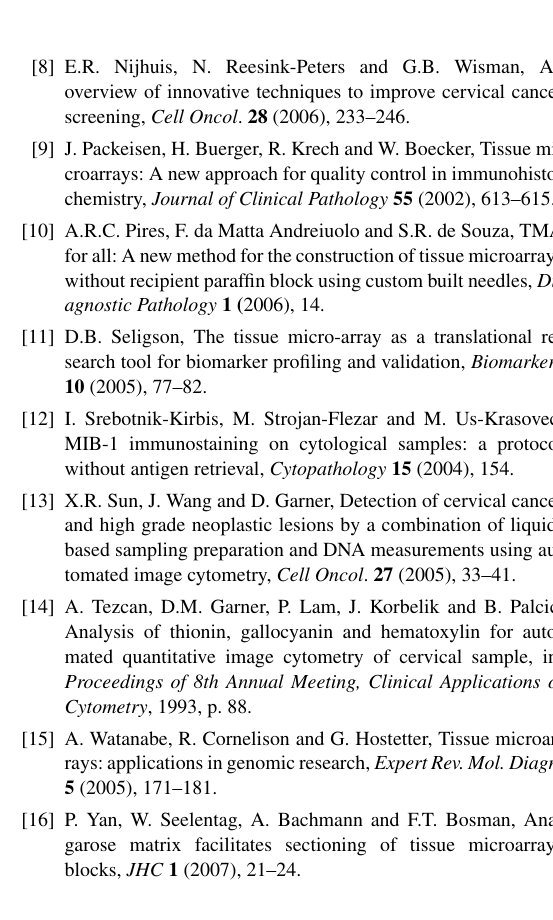
Fig. 12. Five by twelve cytology microarray spotted slide, a magnified (20 × ) image of 2 bronchial lavage sample spots (A, B) and 2 liquid based cervical cytology spots (C, D) stained with Papanicolau